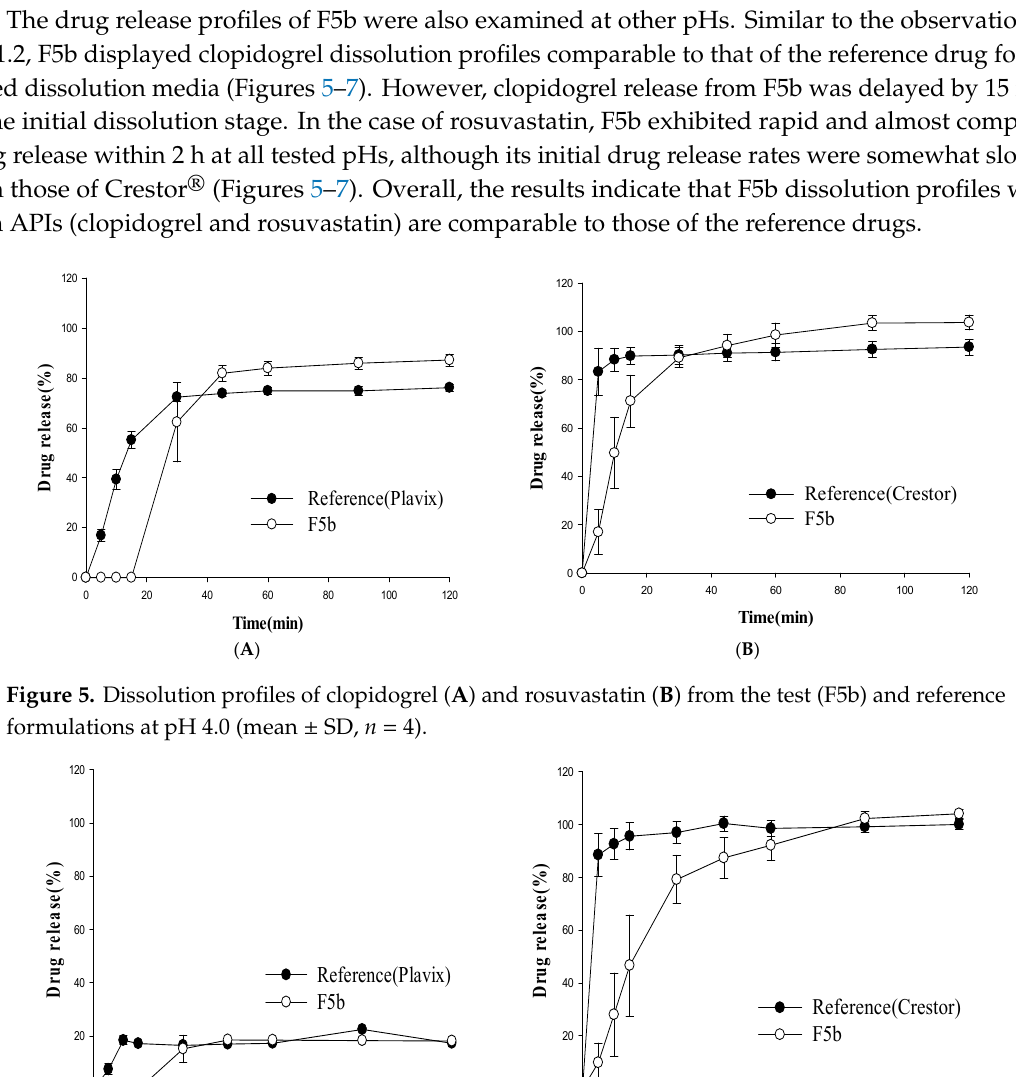
Figure 4. Dissolution profiles of clopidogrel ( A ) and rosuvastatin ( B ) from different formulations at pH 1.2 (mean ± SD, n = 4).